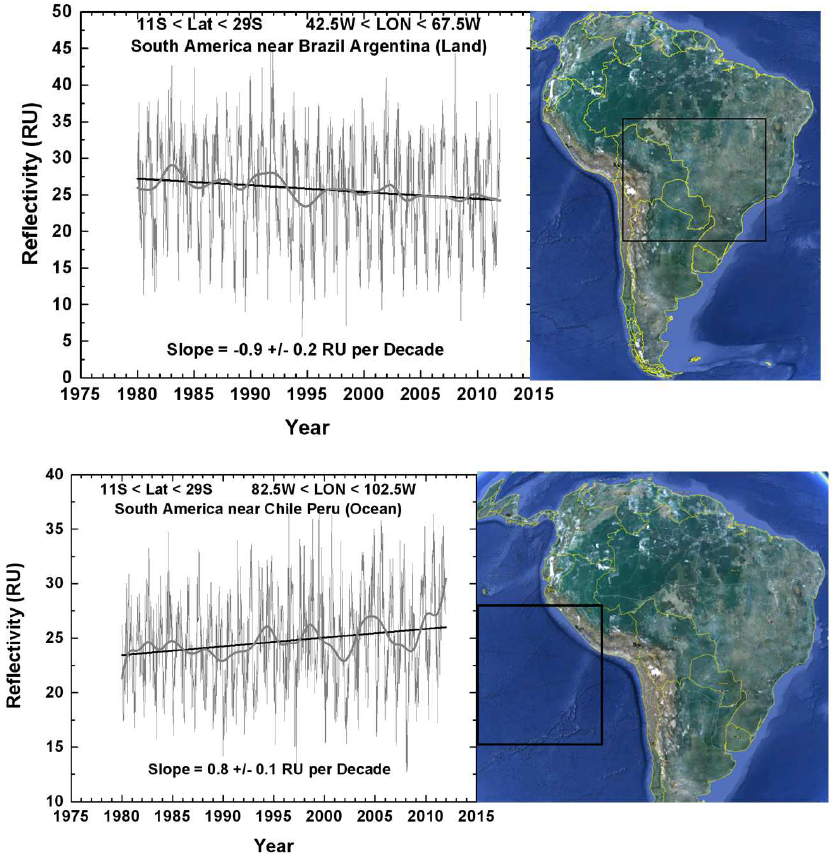
Fig. 15. LER( θ , ϕ ) and 1 LER( θ , ϕ ) for the indicated latitude × longitude boxes showing the decrease in LER over land and the increase over a small region of Chile and Peru. Both daily data and 365-day low-pass filter are shown.